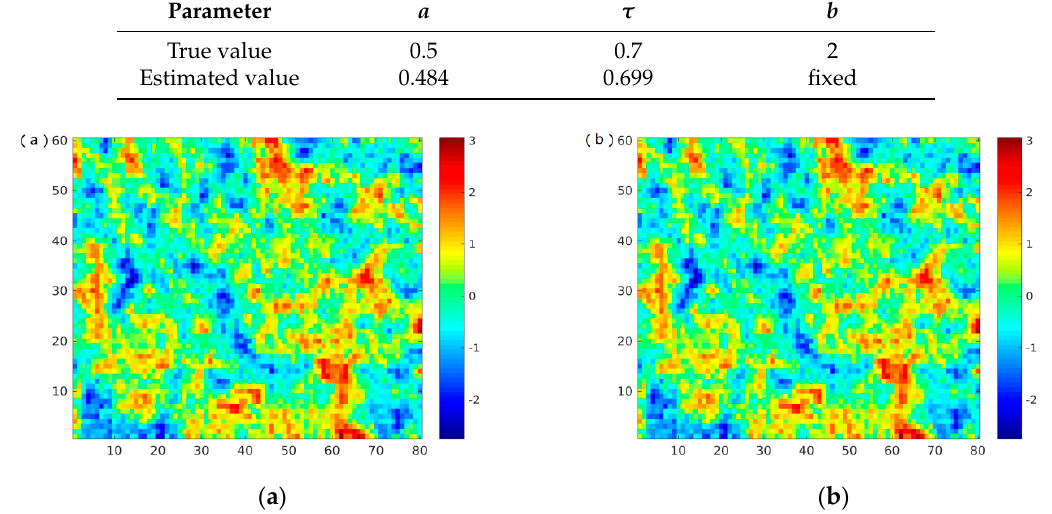
Figure 2. The true field ( a ), the estimated field ( b ). The true field is simulated with a = 0.5, τ = 0.7 and b = 2. Table 1. The results of the parameters from the synthetic data.